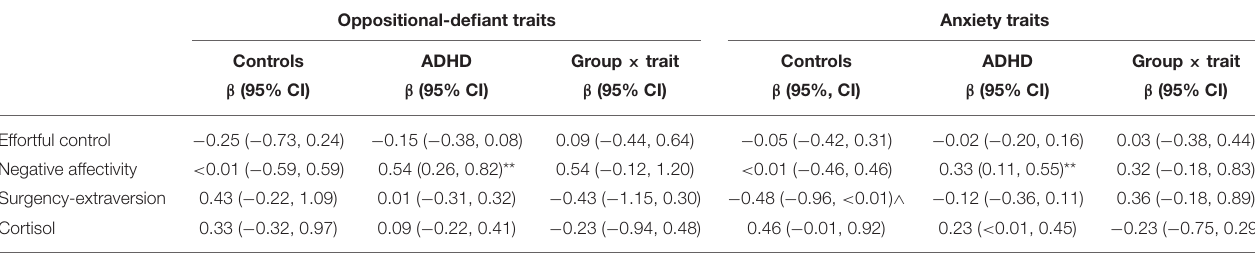
TABLE 3 | Results of regression model analyses showing the association of oppositional-defiant and anxiety traits with the three temperament dimensions and awakening cortisol levels, as well as interaction effects of these psychiatric traits with diagnostic group. Oppositional-defiant traits Anxiety traits Controls ADHD Group × trait Controls ADHD Group ×